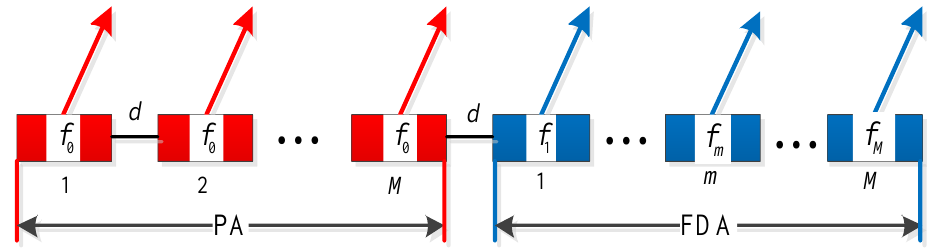
Figure 2. ULA of the proposed PA-FDA dual-mode